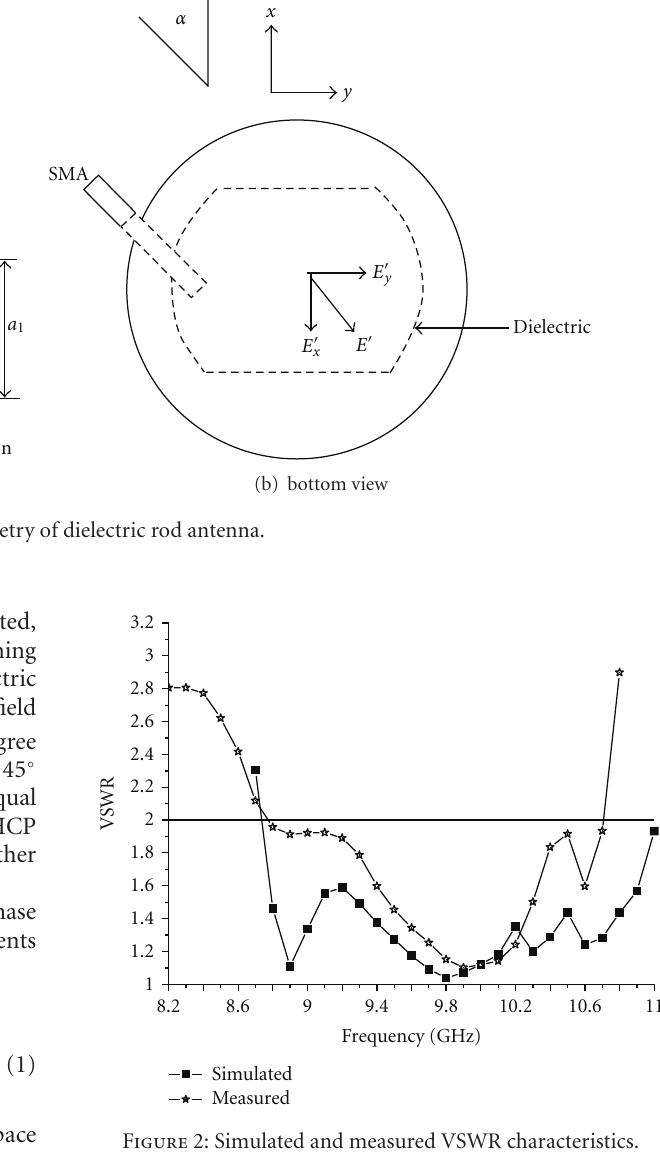
Figure 2: Simulated and measured VSWR